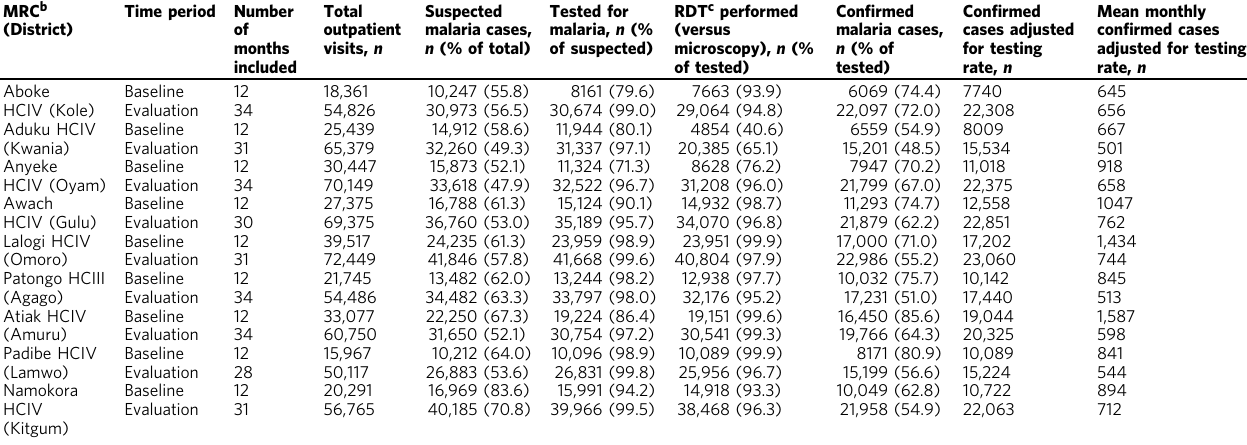
Table 2 Summary statistics from health-facility based surveillance sites that received a single round of IRS a